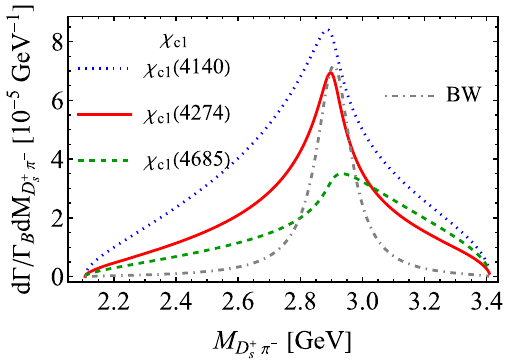
Fig. 3 Invariant mass distributions of D + s π − via the rescatterings in Fig. 1a. The mass and width of intermediate state χ c 1 are taken to be those of χ c 1 ( 4140 ) (dotted line), χ c 1 ( 4274 ) (solid line), and χ c 1 ( 4685 ) (dashed line) given in Eq. (8), separately. The dot-dashed line indicates the T c ¯ s ( 2900 ) BW resonance curve for